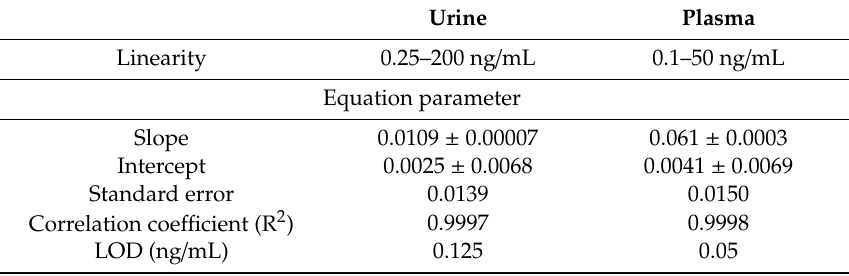
Table 2. Summary of the validation data for IDA quantification in human plasma and urine by the SPE-LC-FL method ( n =